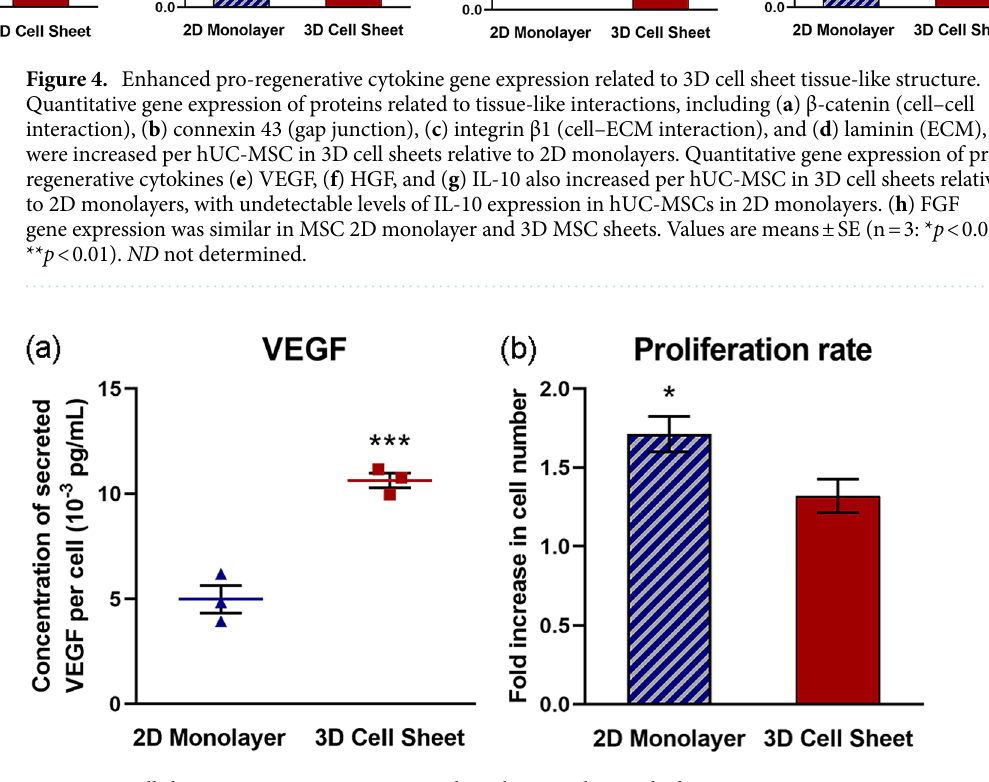
Figure 5. Cell sheet contraction increases actual cytokine production by hUC-MSCs. Human VEGF secretion was increased ( a ) 2.1-fold per hUC-MSC in 3D cell sheets compared to 2D monolayers cultured for 24 h. ( b ) The hUC-MSC proliferation rate during this time course was significantly higher in 2D monolayers compared to 3D cell sheets. Values are means ± SE (n = 3: * p < 0.05 and *** p <